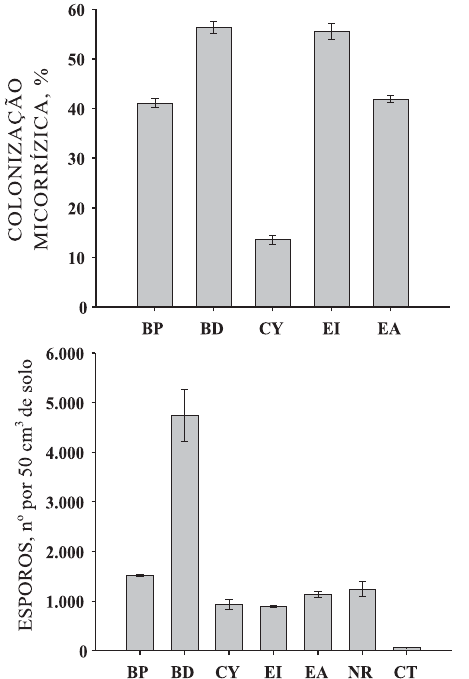
Figura 4. Colonização e densidade de esporos de fungos micorrízicos arbusculares em solos rizosféricos de plantas de crescimento espontâneo de área de “landfarming” de resíduos petroquímicos. BP ( Bidens pilosa ), BD ( Brachiaria decumbens ), CY ( Cyperus sp.), EI ( Eleusine indica ), EA ( Eclipta alba ), NR (Solo não-rizosférico) e CT (Solo-controle sem planta). Linhas verticais indicam o erro-padrão da média (n = 4 repetições para colonização e n = 3 para